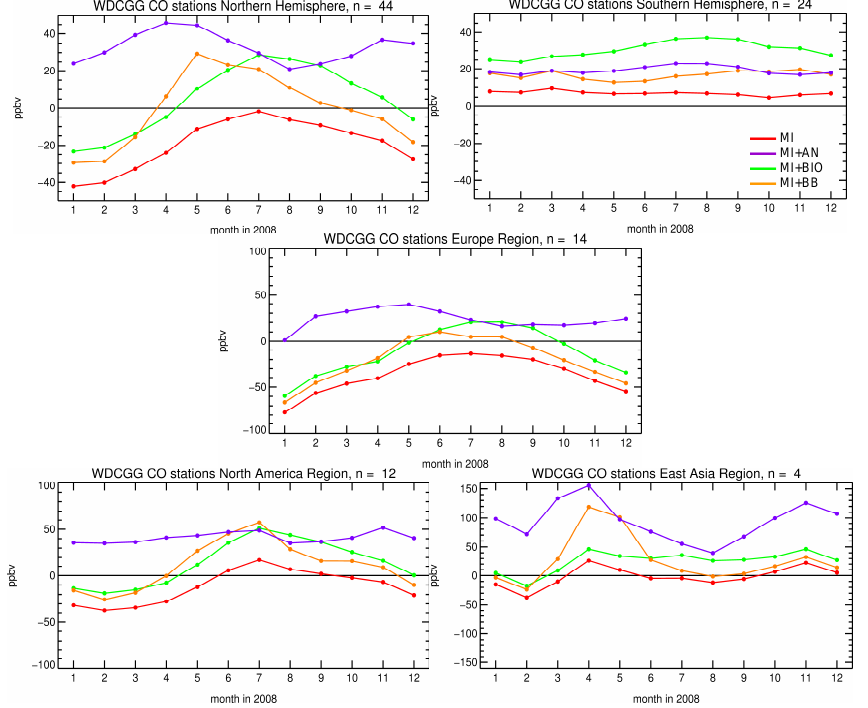
Figure 6. Bias of modelled 2008 monthly mean surface level mixing ratios from the MOZART simulations MI, MI + AN, MI + BIO, and MI + BB compared to observations from WDCGG. n denotes the number of stations